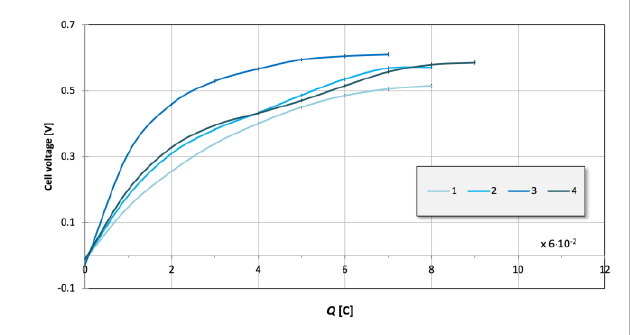
Figure 6. Influence of an anodic charge on the voltage of a half-cell with Cu-Ag (3% of Ag) electrode—influence on the catalytic activity of electrode (lines 1–4 corresponding with 1st, 2nd, 3rd, and 4th anodic charge).